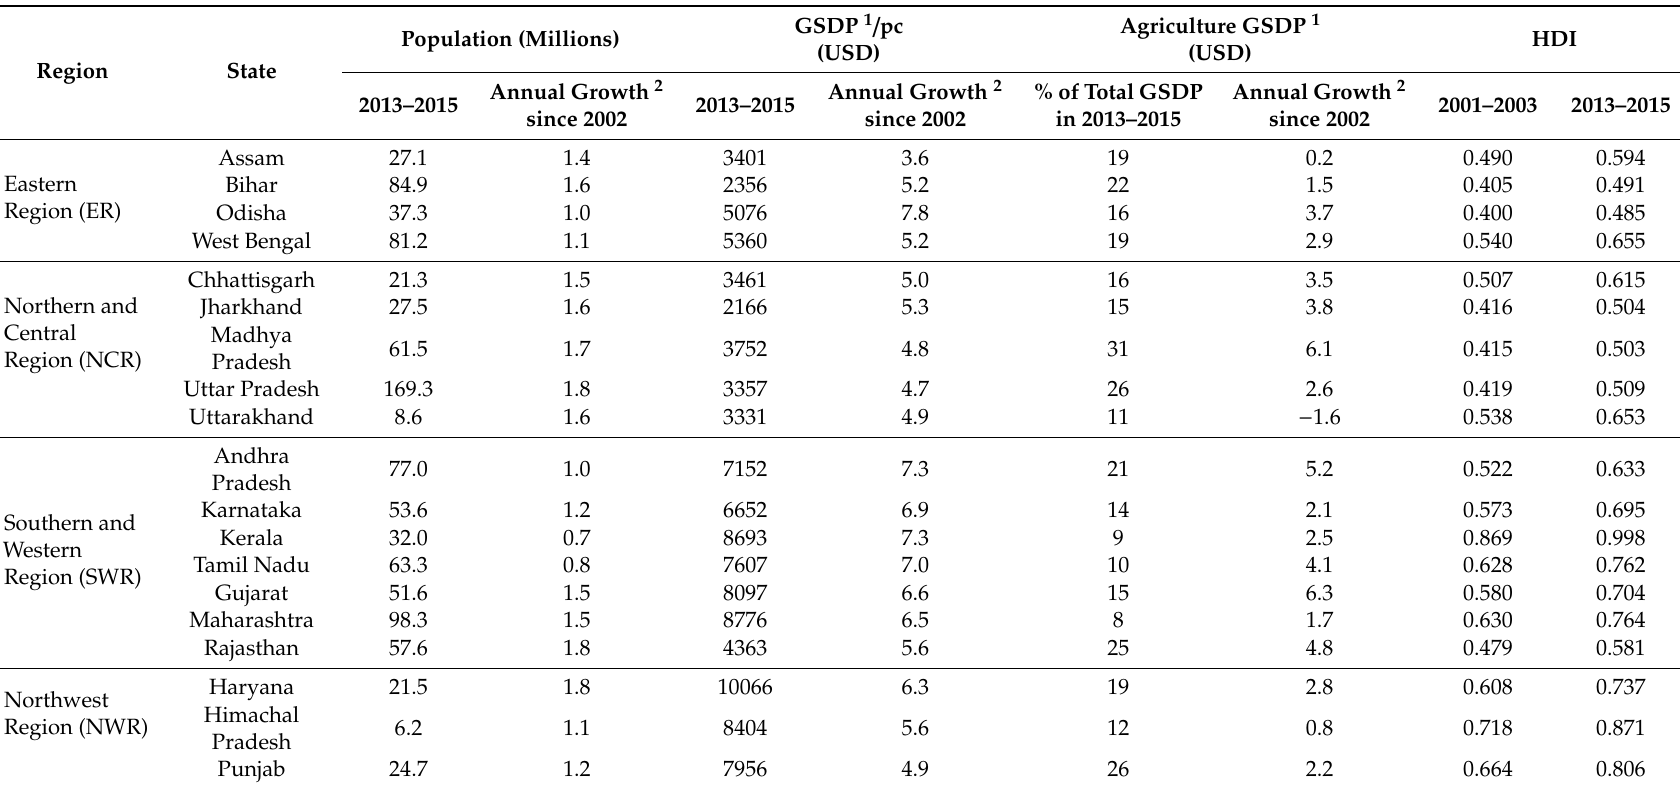
Table 1. Key statistics of the 19 states on the population, gross state domestic product (GSDP) and human development index (HDI).